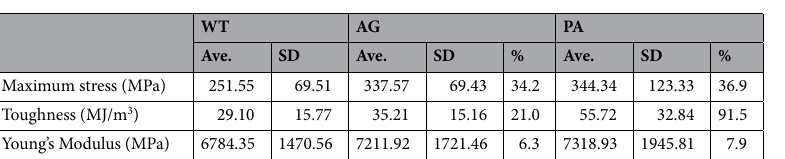
Table 2. Mechanical properties of the Spider Silk Fibers in spider silk-producing PA and AG strains. Ten similarly shaped cocoons from each transgenic and control (non-transgenic) strain were randomly selected, and 5 filaments from different parts of every cocoon were used to measure the mechanical properties at a speed of 2 mm/min. The average and SD values were derived from fifty biological replicate experiments.